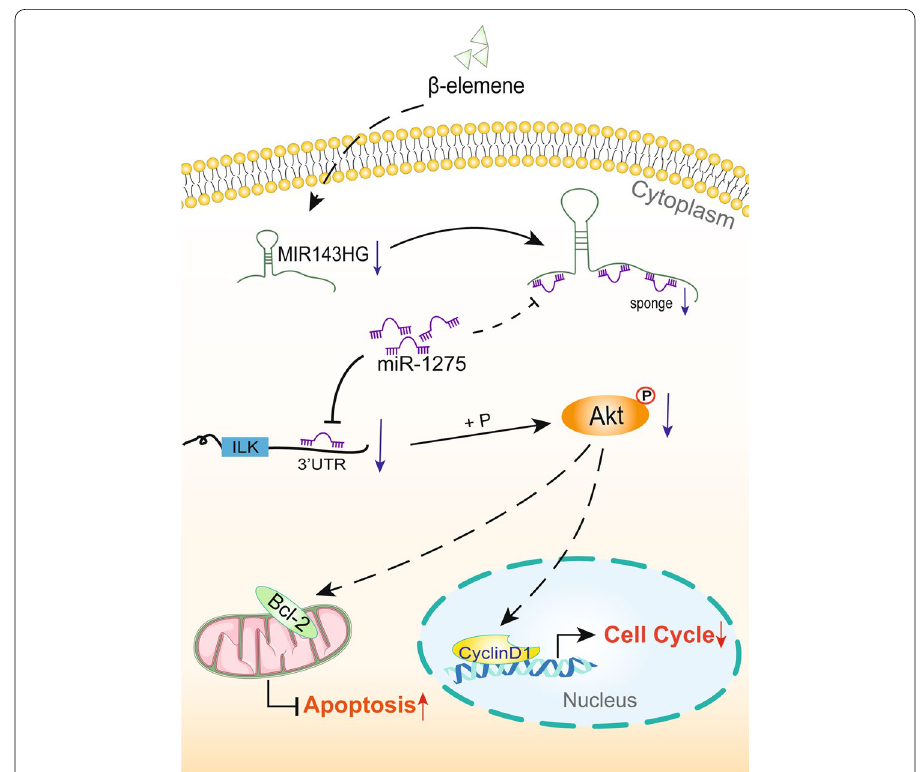
Fig. 7 Schematic diagram of the proposed mechanism by which β-elemene regulates the cell cycle and apoptosis in PHAGF: Both MIR143HG and ILK may act as a ceRNA to sponge miR-1275. MIR143HG/miR-1275/